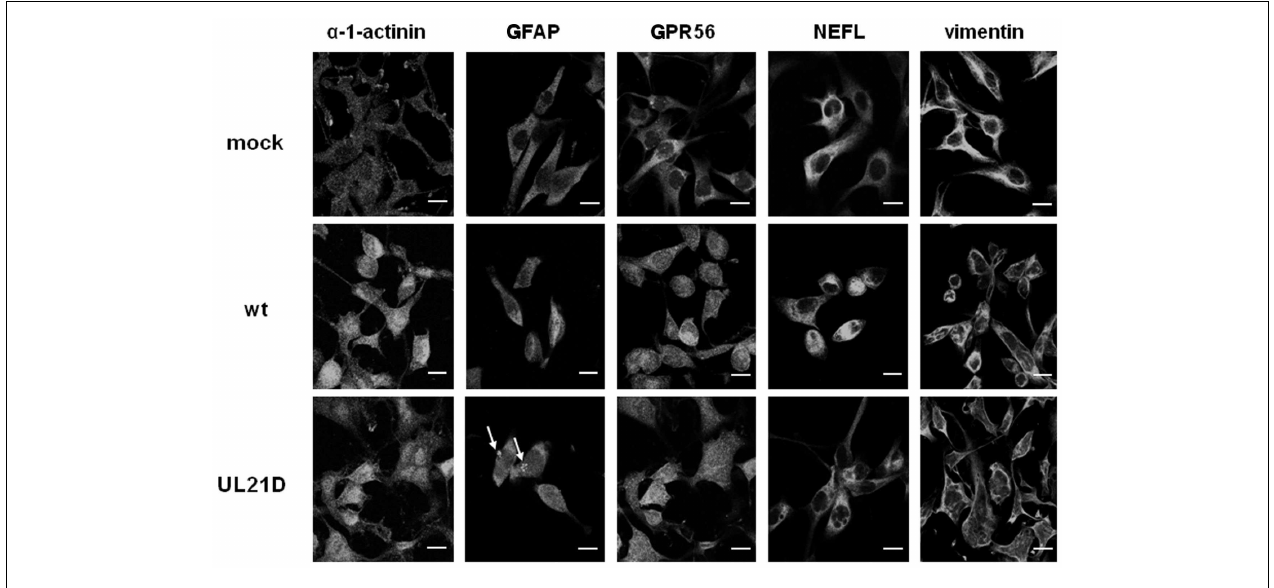
-vimentin antibodies followed by Alexa Fluor®-conjugated secondary antibodies, and examined under a confocal immunofluorescence microscope. Arrows indicate GFAP accumulation. Bars indicate 20 µ